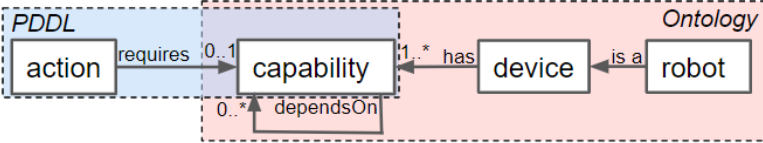
Figure 4. Outline of what we define action, capability, device and robot as. PDDL actions require a capability and devices along with what they are capable of are defined in an